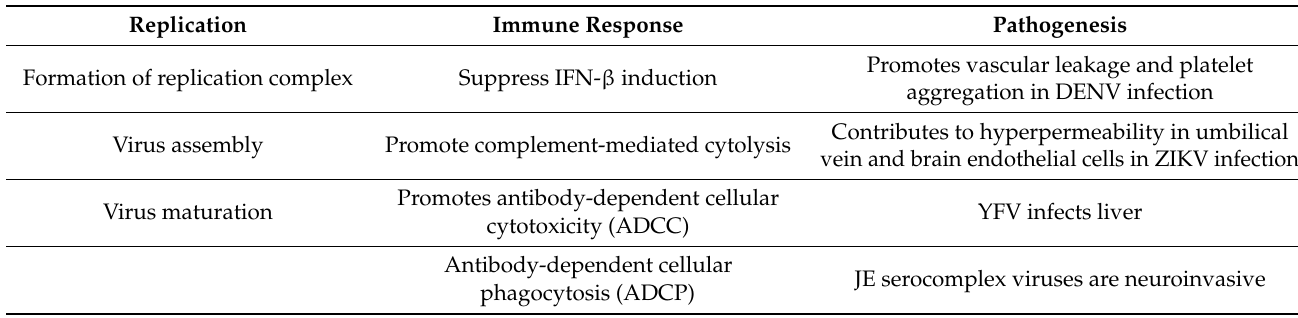
Table 2. Known roles of